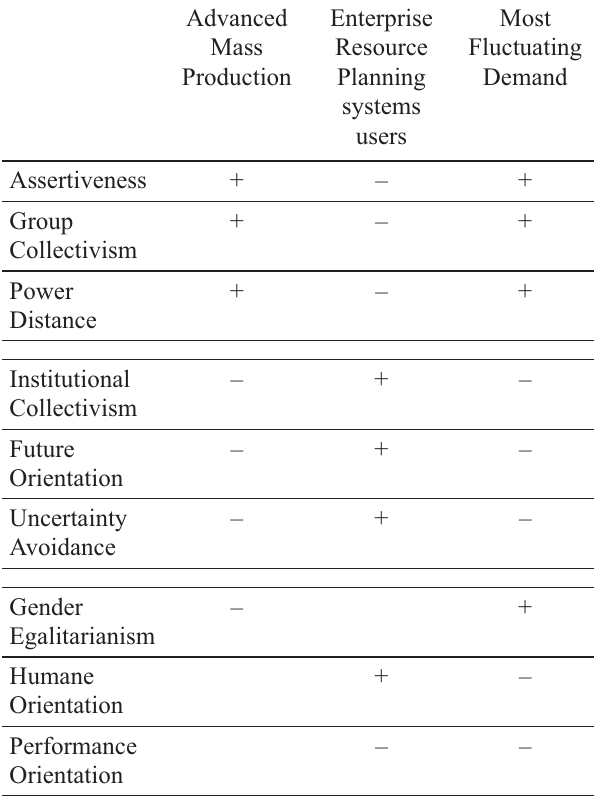
Table 3. Connections between Manufacturing